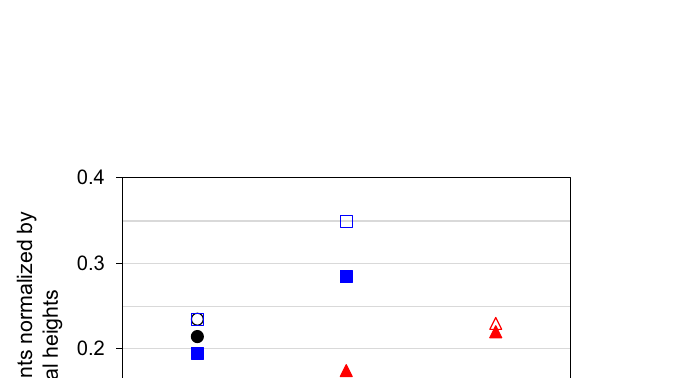
Figure 9. The horizontal granular displacements versus the initial distance perpendicular to the slope surface in the mid-slope. The green strip (4 mm width) shows the range of selected grains.